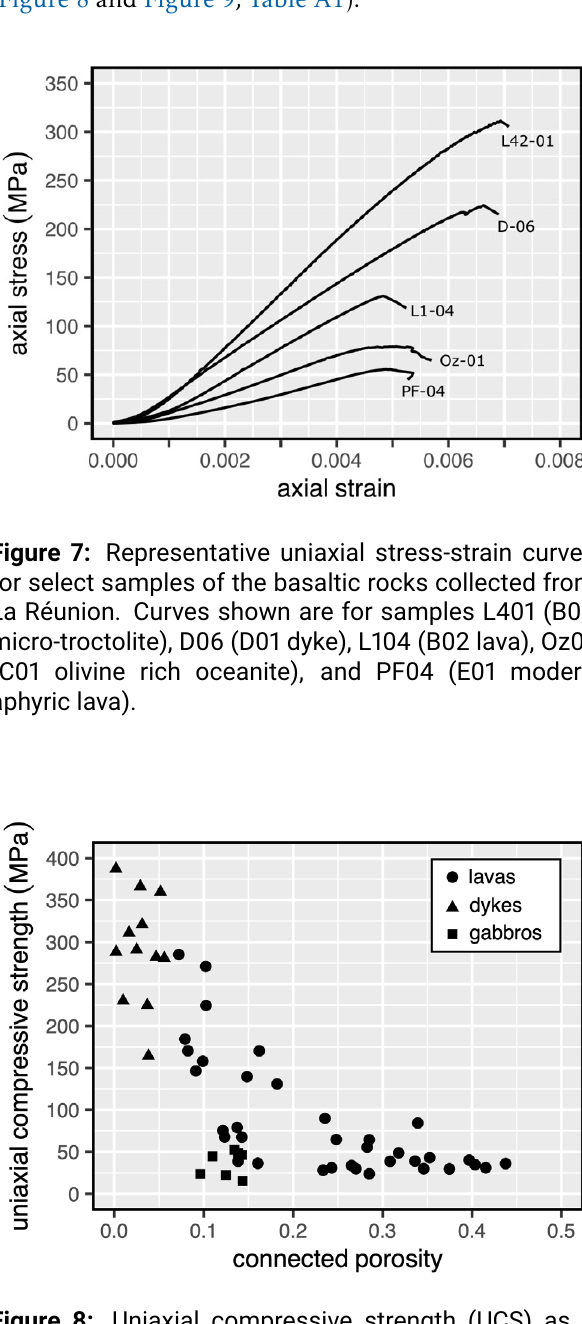
Figure 8: Uniaxial compressive strength (UCS) as a function of total porosity for the basaltic rocks from La Réunion (data available in Table A1).